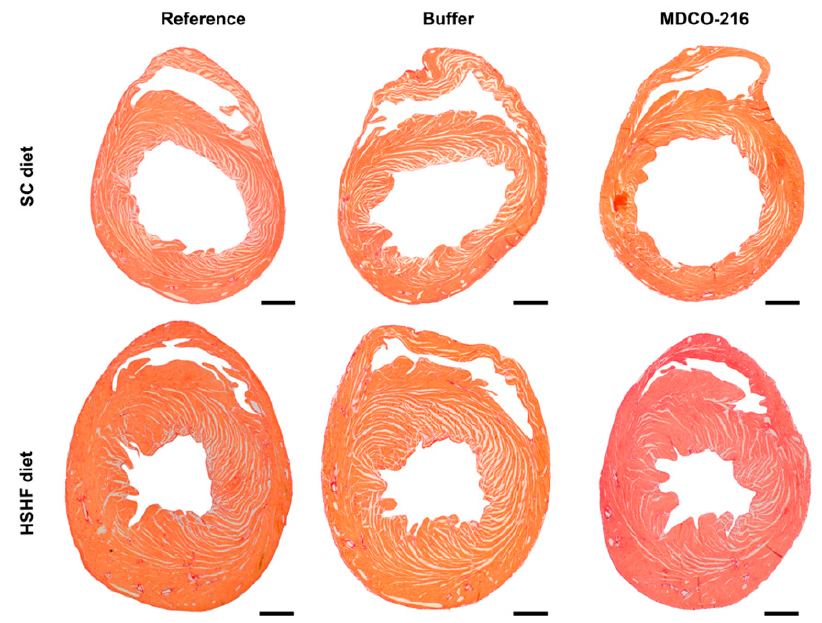
Figure 5. Representative Sirius-red stained heart cross-sections of reference, buffer, and MDCO-216 SC diet and HSHF diet mice. Scale bar represents 1 mm.